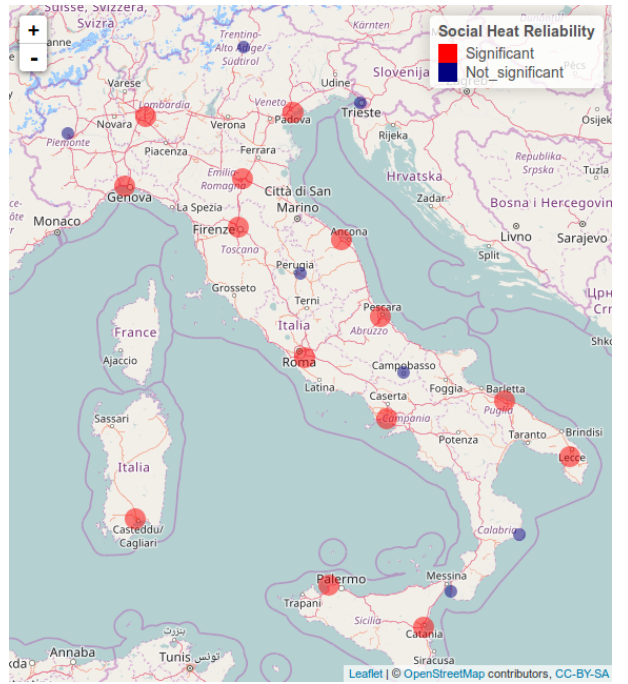
Figure 4. Social heat reliability in several Italian cities. Read spot: significant association; blue spot: not significant